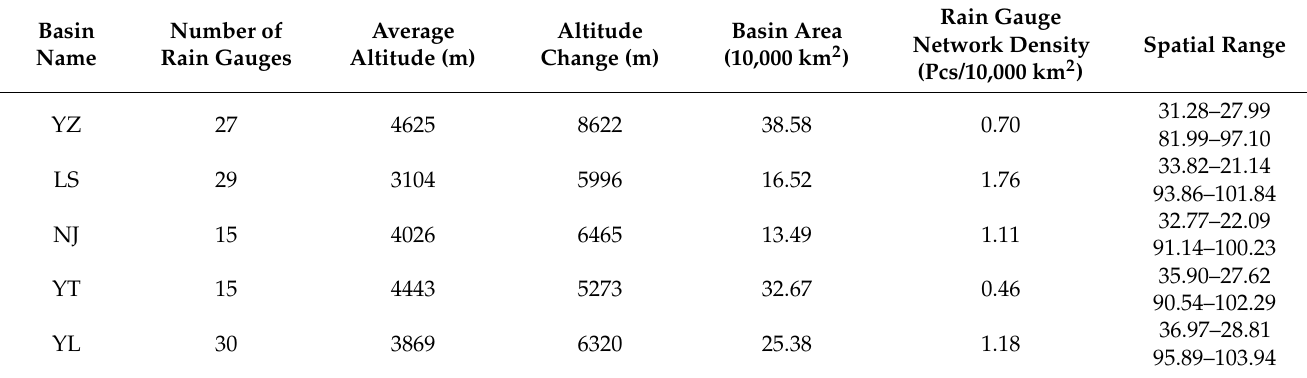
Table 2. Distribution of rain gauge stations in five basins of southwest